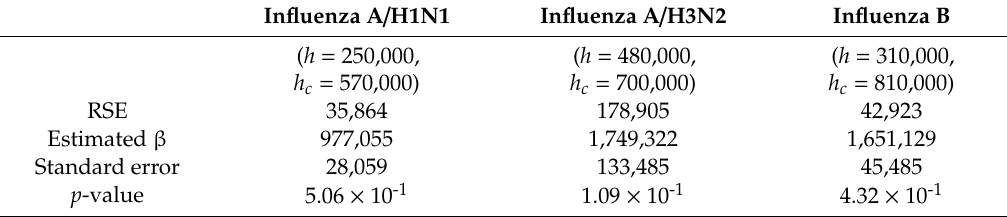
Table 1. Prediction models of the epidemic sizes of influenza A / H1N1, A / H3N2, and